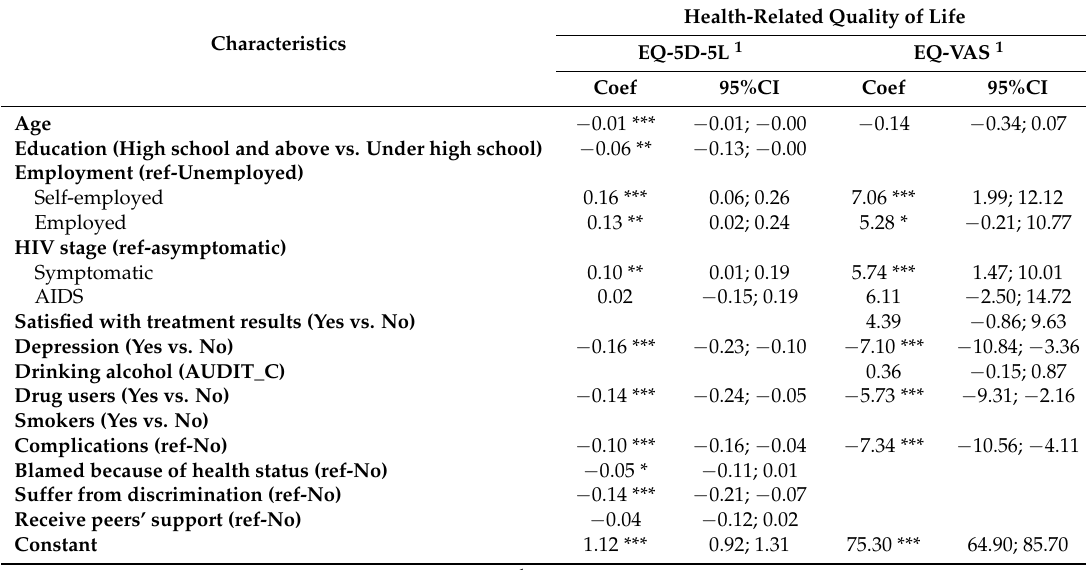
Table 7. Factors associated with health-related quality of life (HRQOL) among patients receiving ART.